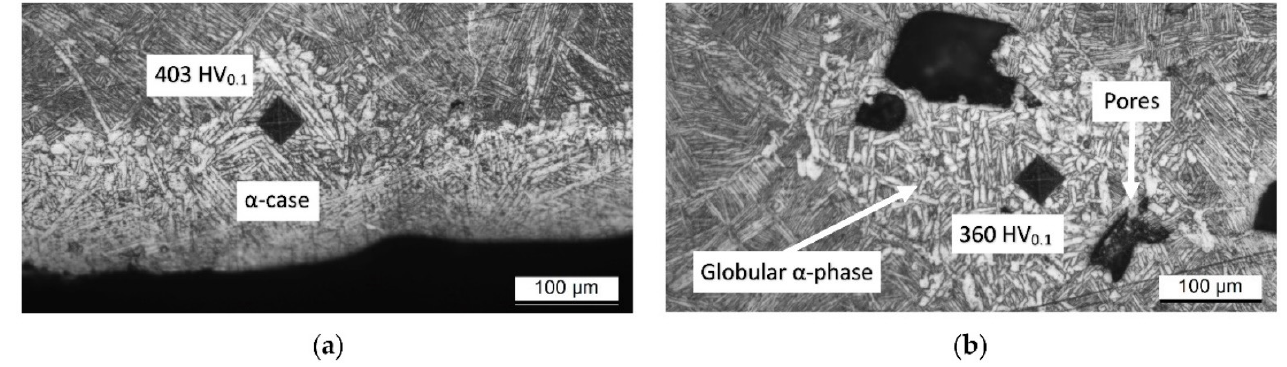
Figure 15. Representative HV 0.1 indentations performed on the α -case layer ( a ) and on the globular α -phases in the center of the bar ( b ).